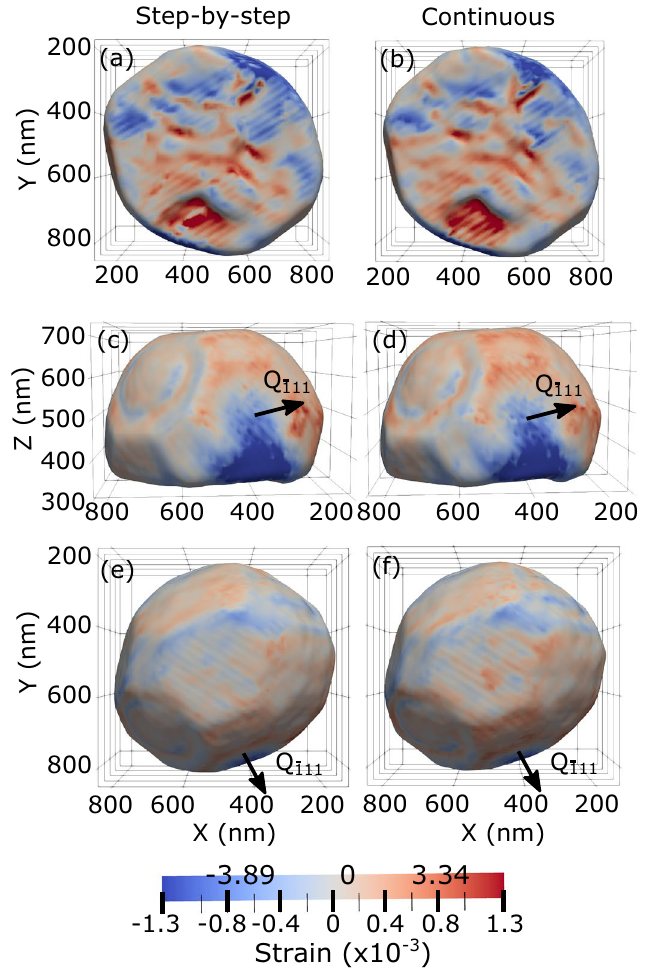
Figure 2. Comparison of the retrieved surface strain in 3D. Bottom ( a , b ), side ( c , d ) and top ( e , f ) views of the ¯ 111 BCDI reconstruction of strain field along the [ ] direction, ε ¯ 111 , drawn at 30% of the maximum Bragg electron density of the Pt nanoparticle measured by conventional step-by-step ( a , c , e ) and continuous ( b , d , f ) scanning. The direction of the scattering vector, Q ¯ 111 , is indicated in the